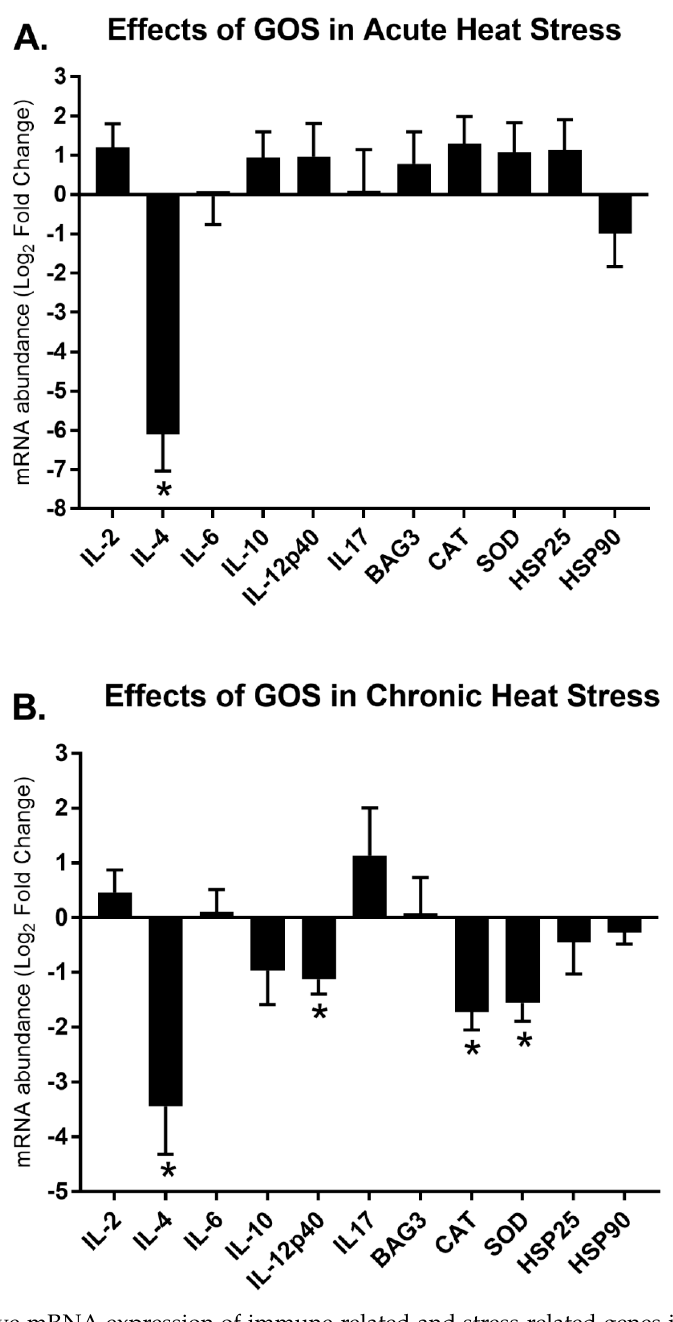
Figure 2. Relative mRNA expression of immune-related and stress-related genes in the spleens of slow-growing chickens injected in ovo with GOS and challenged with heat on two levels: A —acute (30 ◦ C for 8.5 h); and B —chronic (30 ◦ C for 14 days). Gene panel includes: interleukin: IL-2 , IL-4 . IL-6 , IL-10 , IL-12p40 , IL-17 and stress-related genes: CAT, SOD, BAG3, HSP25 and HSP90. X-axis shows a list of genes. Y-axis indicate relative mRNA abundance of the genes after heat challenge (n = 8). Gene expression analysis was carried out with RT-qPCR. qPCR reactions were performed in triplicates. Geometric mean of ACTB and UB reference genes was used to calculate dCt values. The relative gene expression was calculated with ddCt formula (FC= 2 −ΔΔ Ct ). FC values were transformed and presented as Log 2 FC. Standard error of the means (SEM) shows distribution of the Ct values. Normalized data (dCt values) of heat-challenged (A-acute, B-chronic) control (mock-injected) and heat-stressed GOS treatment groups were compared with Student’s t-test. Significant di ff erences ( p < 0.05) were labelled with an asterisk (*). Figures were prepared by using GraphPad Prism 7 (GraphPad, La Jolla, CA,